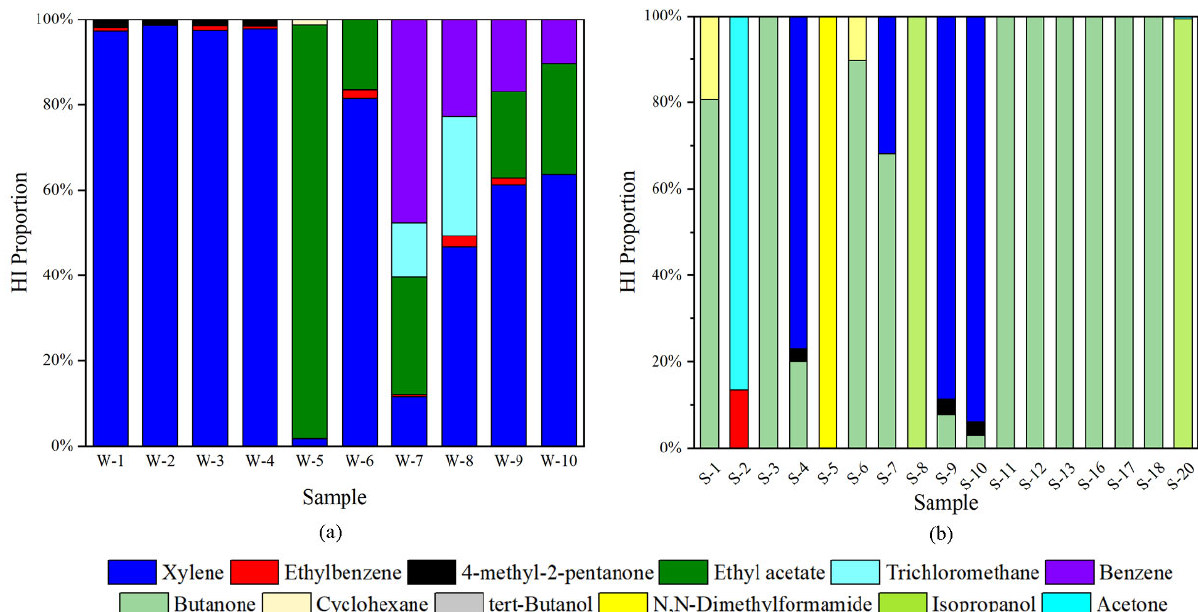
Figure 7. Proportions of the noncancer risks of volatile compounds emitted from white emulsion adhesives ( a ) and silicone adhesives ( b ).